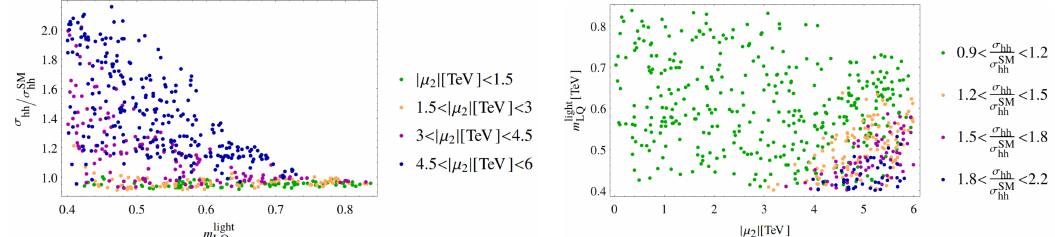
Figure 8. Left: LO σ hh normalized with respect to the SM one, as function of the lightest LQ mass m light in TeV, in colors the values of | µ 2 | . Right: LO σ hh normalized with respect to the SM LQ one, as function of µ 2 and m light , in colors the values of σ hh /σ SM LQ